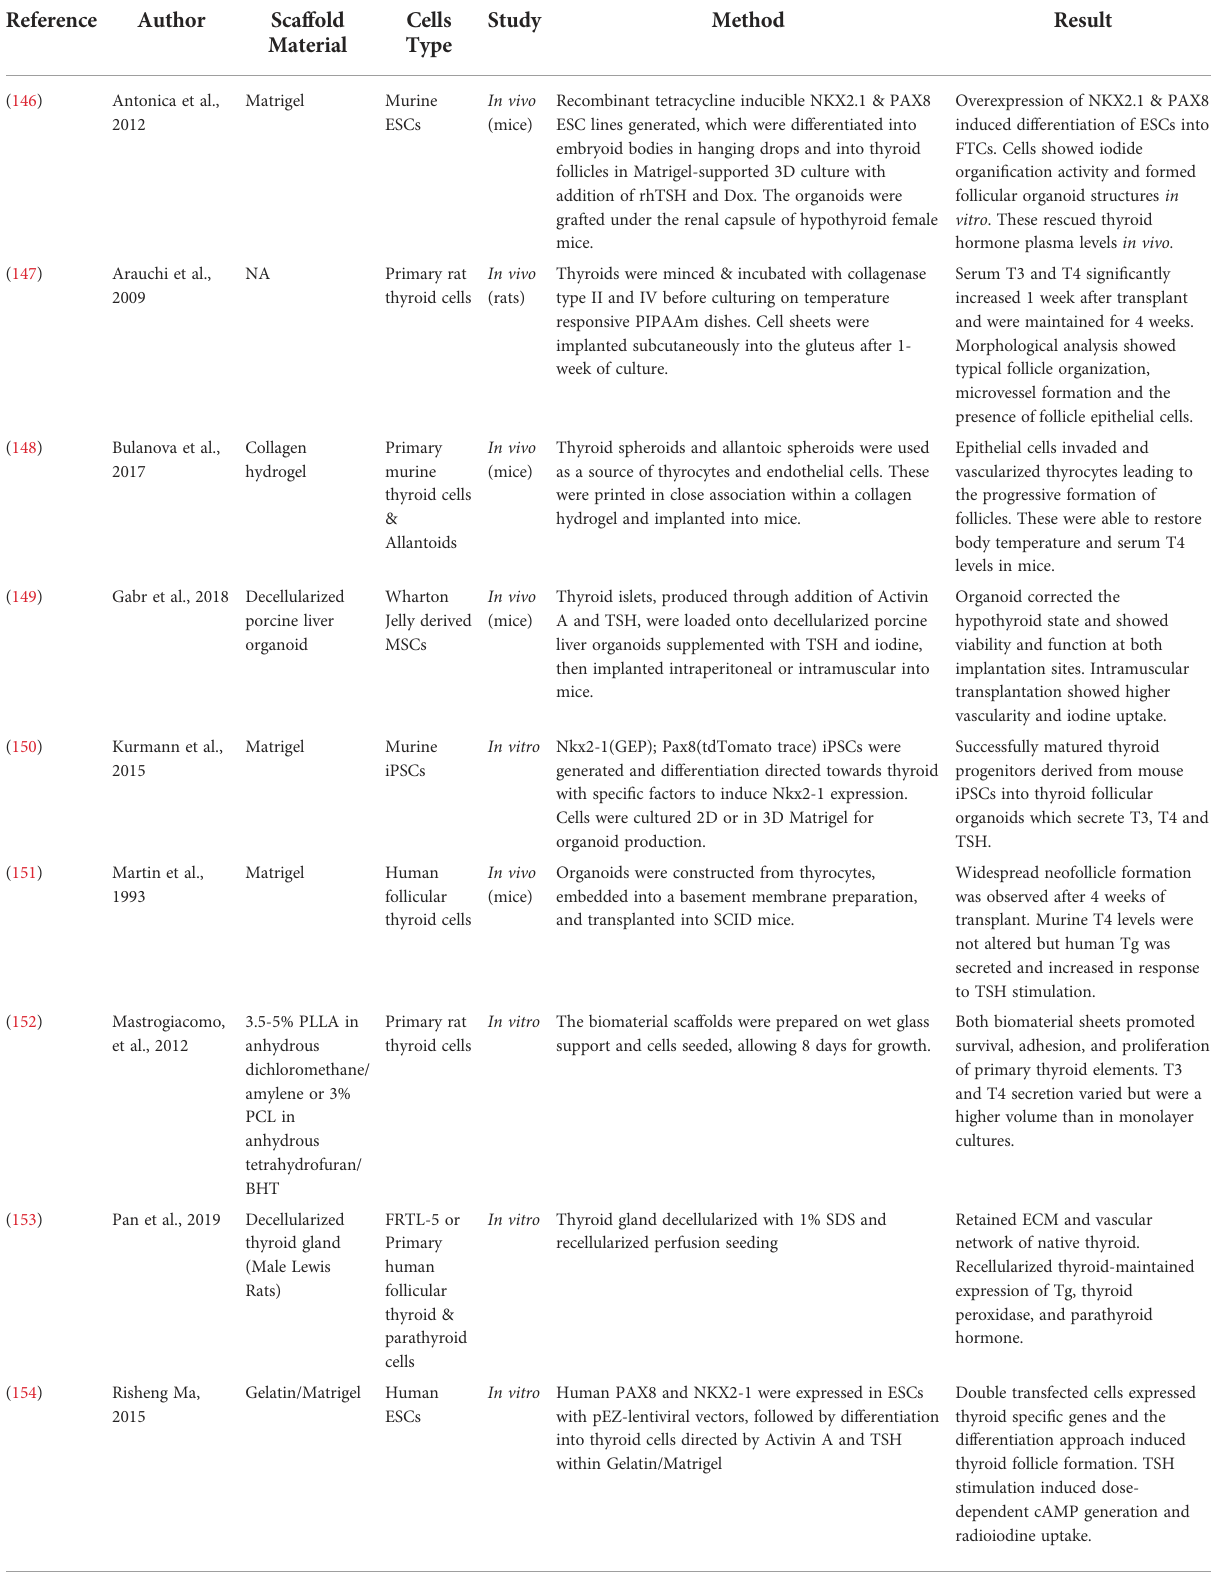
TABLE 3 Novel bioengineering and regenerative medicine approaches to produce treatments for